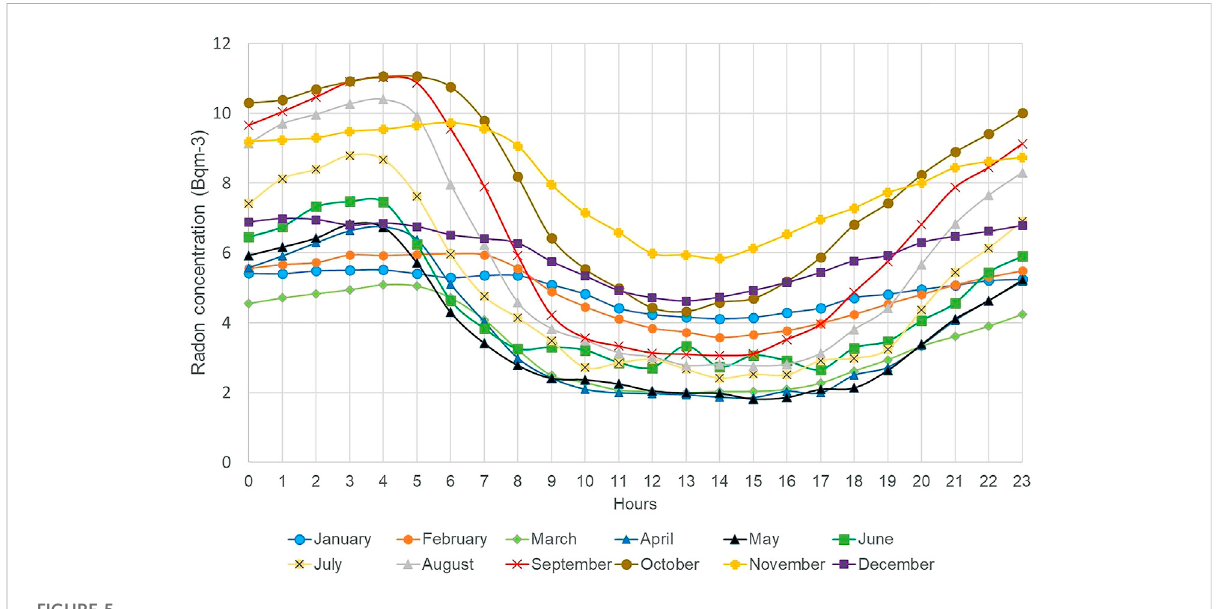
FIGURE 5 Monthly averaged mean diurnal cycle of all radon concentration measurements.